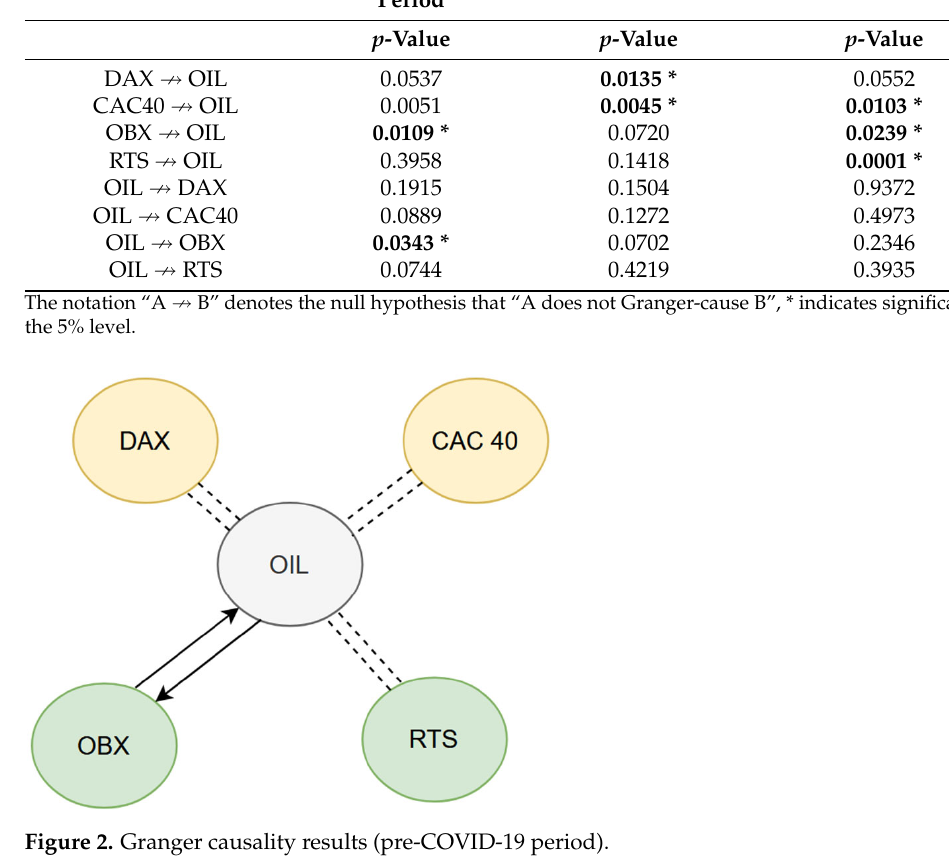
Table 3. Granger Causality Test.